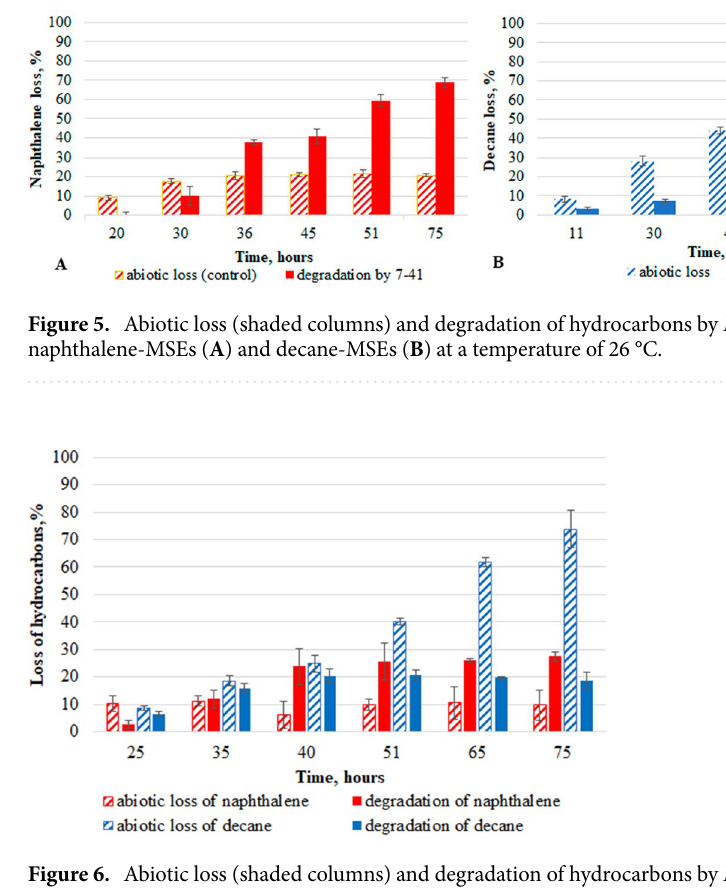
Figure 6. Abiotic loss (shaded columns) and degradation of hydrocarbons by P. veronii 7–41 in BSEs (naphthalene-red and decane-blue) at a temperature of 26 °C.